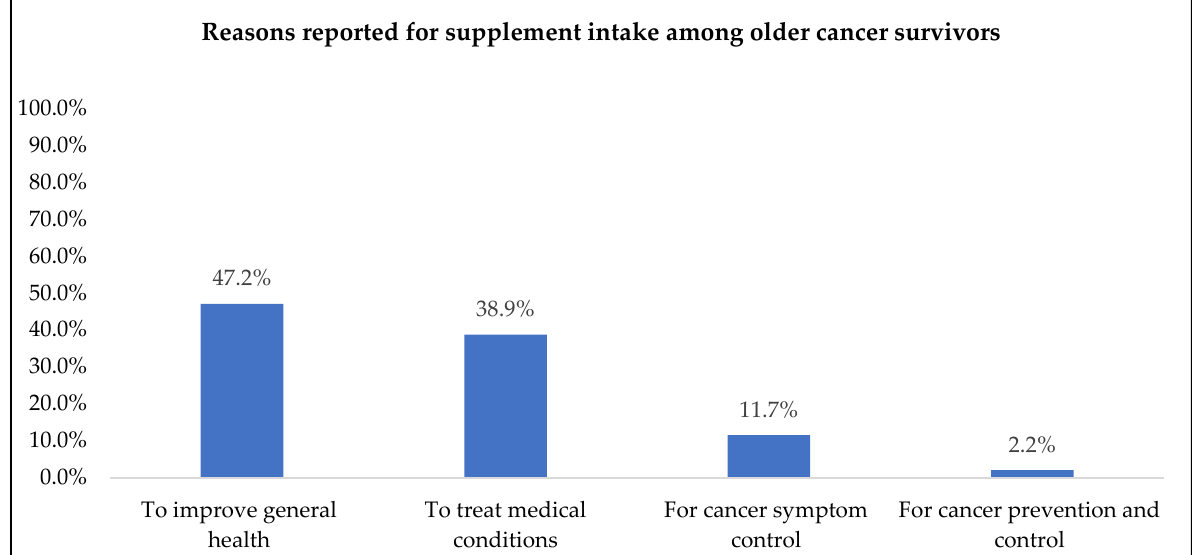
Figure 2. Primary reasons reported for dietary supplement use among older cancer survivor sup- plement users ( n = 215).